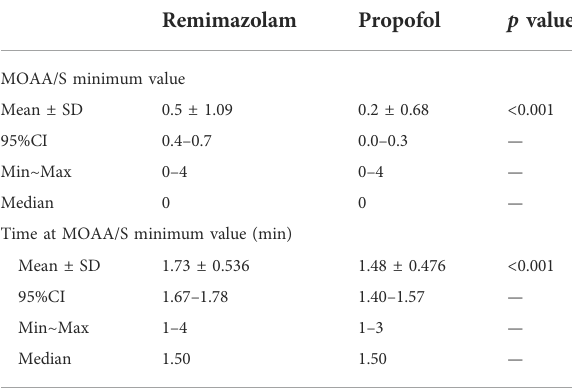
TABLE 7 Minimum MOAA/S score after fi rst administration of study drug and prior to fi rst top-up of study drug. Remimazolam